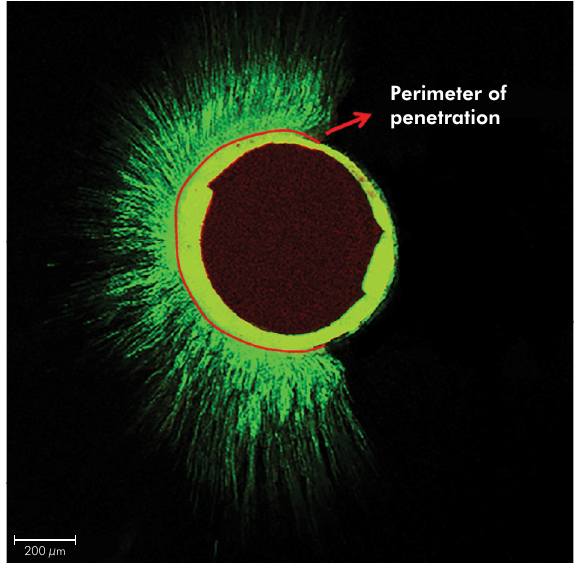
Figure 2. Image recorded in the confocal laser scanning microscope with penetration perimeter (red